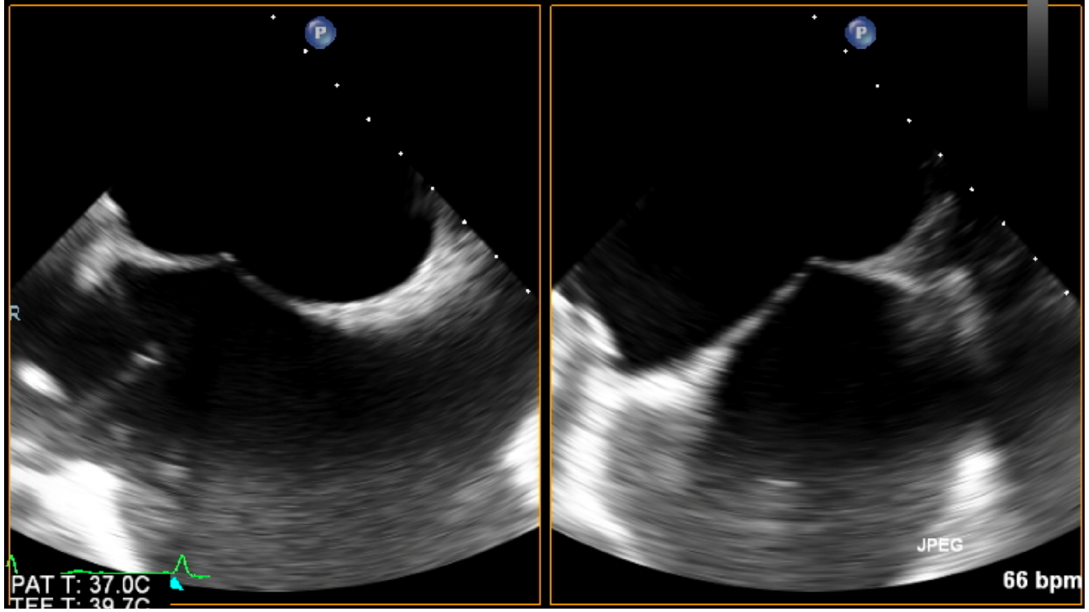
Figure 3. Biplanar imaging of the interatrial septum tenting produced by the tip of the transseptal sheath.